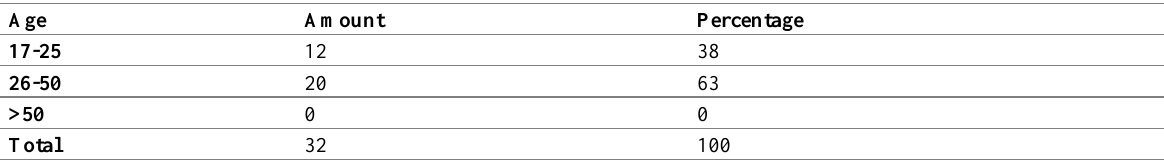
Table 2: Age of Respondents